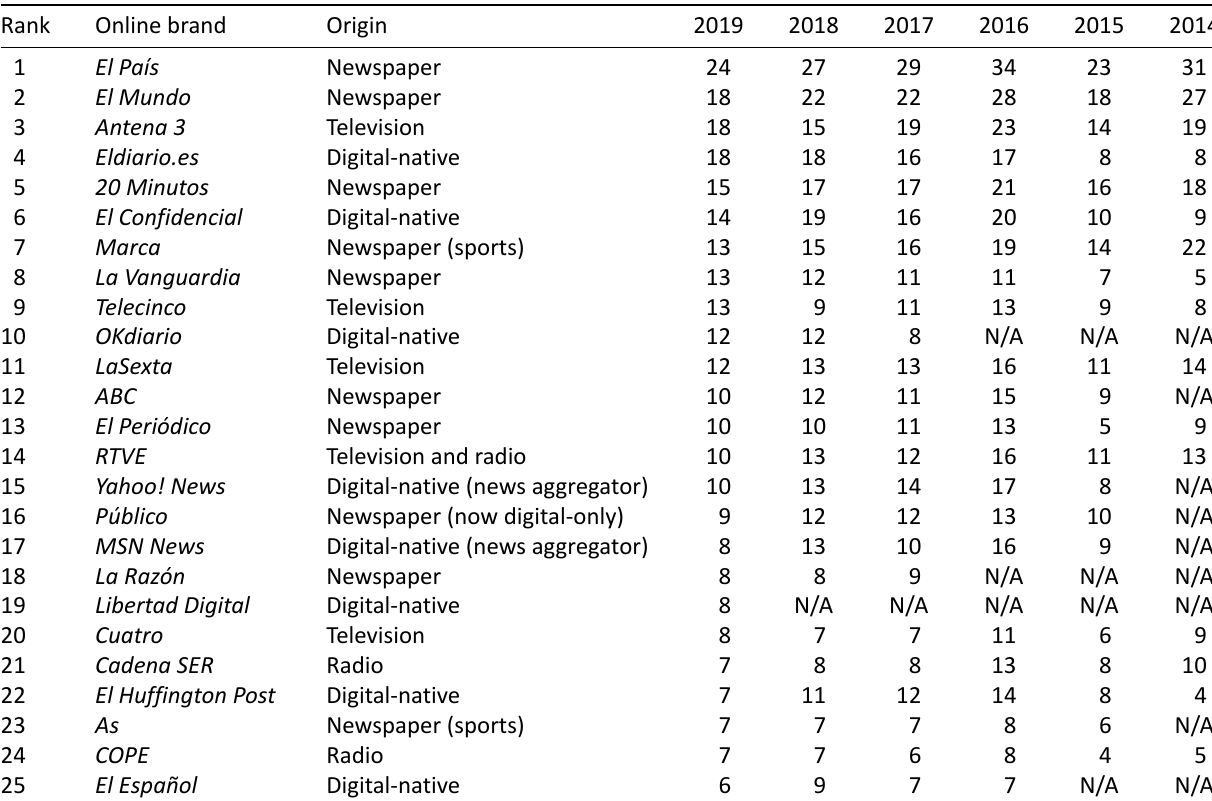
Figure 2. Number of active digital-native sites in Spain with known launch year, by year (N = 1,750, November 2019). Notes: Launch year not determined for 164 active and 249 inactive sites. Closure year not determined for 171 inactive sites. Source: Authors’ own database. Table 3. Weekly online reach for news (%) among adult digital news users in Spain (N ≈ 2000, January–February of each